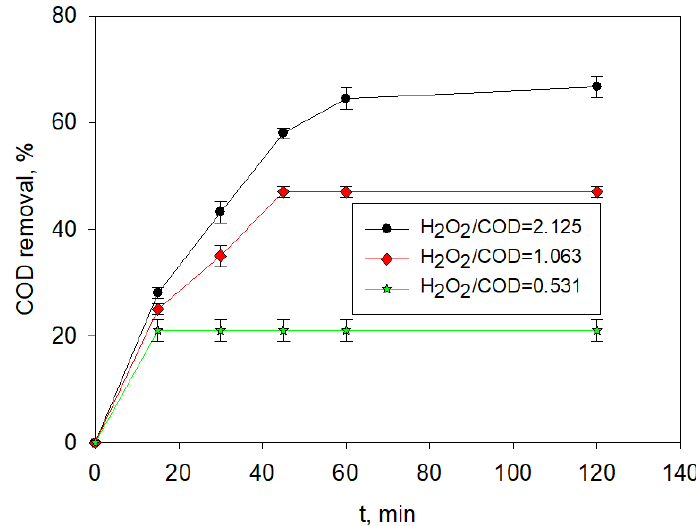
Figure 4. COD removal along the UVA-LED photo-Fenton treatment (considering different [H 2 O 2 ]:COD ratios) of mature LL pre-treated by an optimized electro-coagulation followed by a conventional coagulation CC pretreatment combination. Table 3. Summary of results of the UVA-LED photo-Fenton treatment of mature LL pre-treated by an optimal electro- coagulation followed by an optimized conventional coagulation pre-treatment combination. UVA-LED Photo-Fenton UVA-LED Raw LL [H 2 O 2 ]:COD = 2.125, 120 min